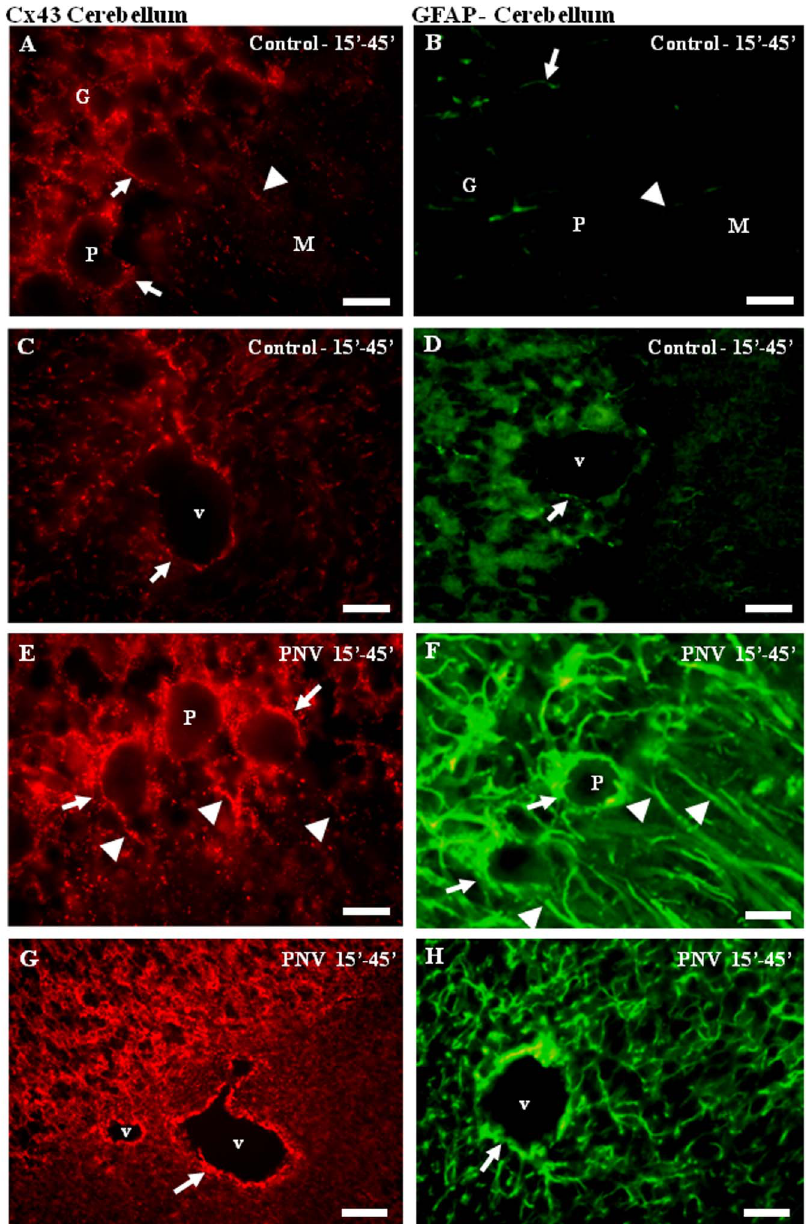
Figure 7. Cx43 and GFAP imunofluorescence in sections of cerebellum. A, C, E, G represent Cx43 and B, D, F, H represent GFAP immunolabeling. A–D showed control group and E–H showed PNV-15-45 9 group. There is a correlation between Cx43 and GFAP labeling (arrows and arrowheads). This indicated that Cx43 are positive mainly in astrocytes. G= Granular layer, P= Purkinje layer, M= Molecular layer, v= blood vessel. Bar =70 m m for all panels.